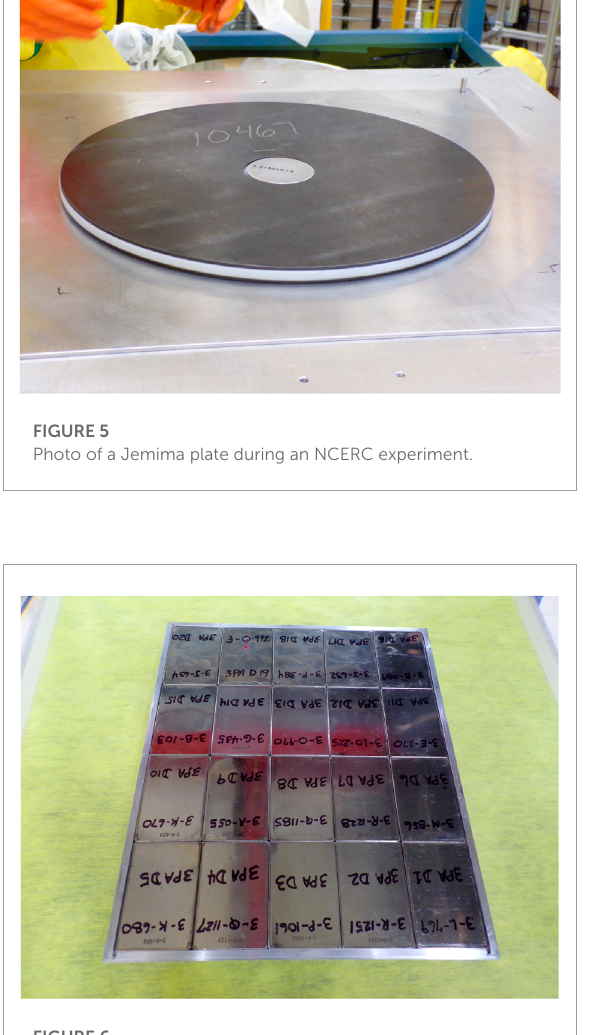
FIGURE 6 Photo of an array of ZPPR plates during the Chlorine Worth